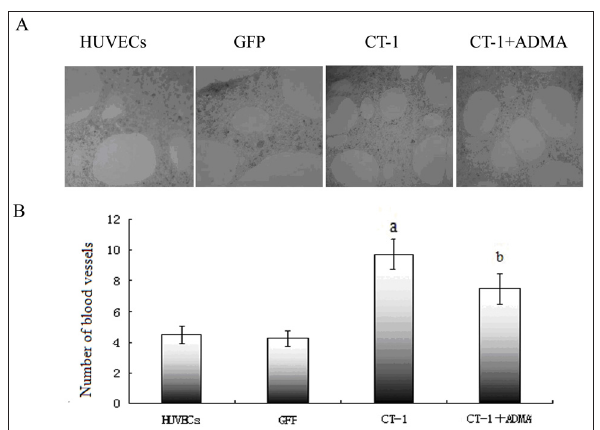
Fig. 5. Tube formation analysis. (A) Representative photomicro- graphs showing effects of CT-1 gene delivery on tube formation. (B) Quantitative analysis of the numbers of blood vessels in different group.